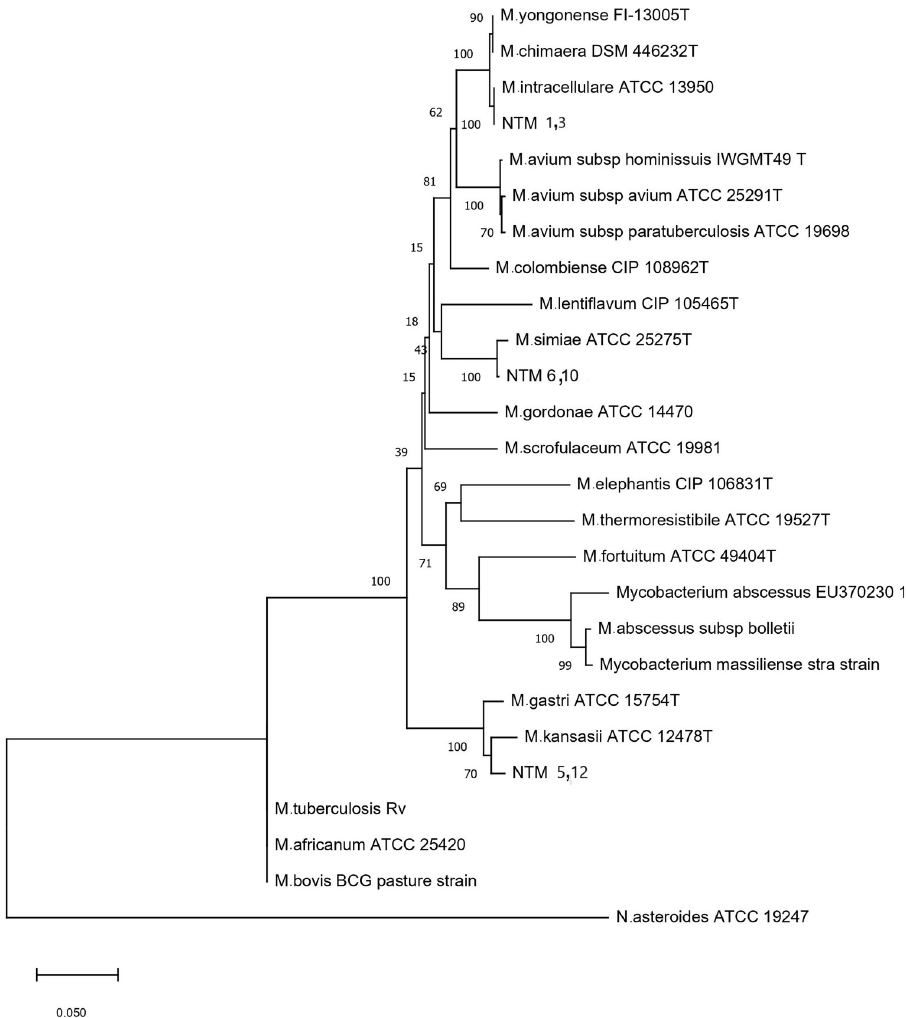
Fig 1. Phylogenetic tree based on rpoB gene sequences. rpoB sequence-based phylogenetic tree of the clinical isolates of NTM with those of closely related species which computed by the NJ analyses and K2P model. The support of each branch, as determined from 1000 bootstrap samples, is indicated by percentages at each node. Bar 0.01 substitutions per nucleotide position.